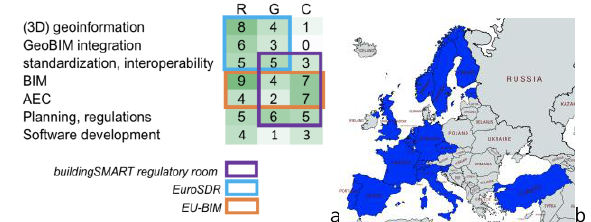
Figure 1. a. Occurrences and distribution of EUnet4DBP skills and scope of the involved associations. b. Countries of origin of network